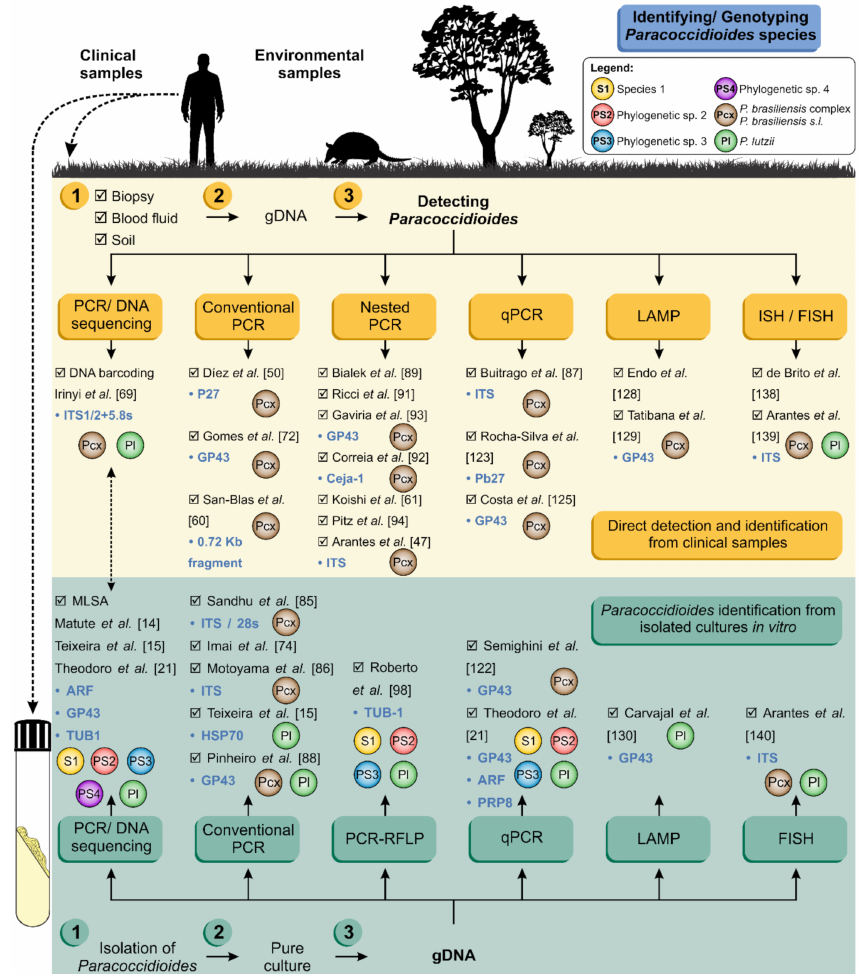
Figure 6. Schematic representation of Paracoccidioides spp. molecular detection / identification pipeline, directly from clinical and / or environmental samples (yellow panel) or from gDNA extracted from cultured isolates (green panel). Breakthroughs are listed, as well as their targeted genes and species discriminationpower. PCR,polymerasechainreaction; RFLP,restrictionfragmentlengthpolymorphism; qPCR, quantitative real-time polymerase chain reaction; FISH, fluorescent in situ hybridization; LAMP, loop-mediated isothermal